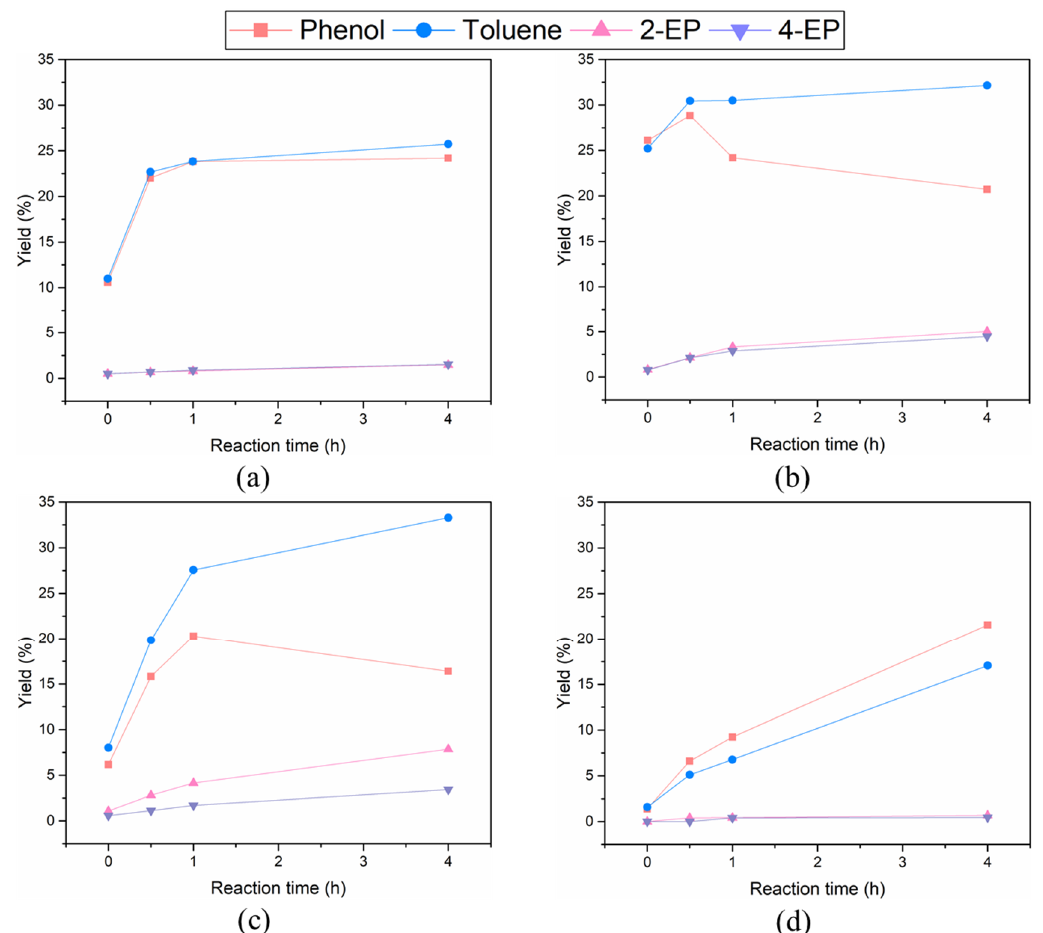
Figure 3. The selectivity of the quantified liquid phase products after the decomposition of BPE over Ru/C ( a ), Pd/C ( b ), Pt/C ( c ), and AC ( d ) at 270 °C for 4 h in supercritical ethanol.